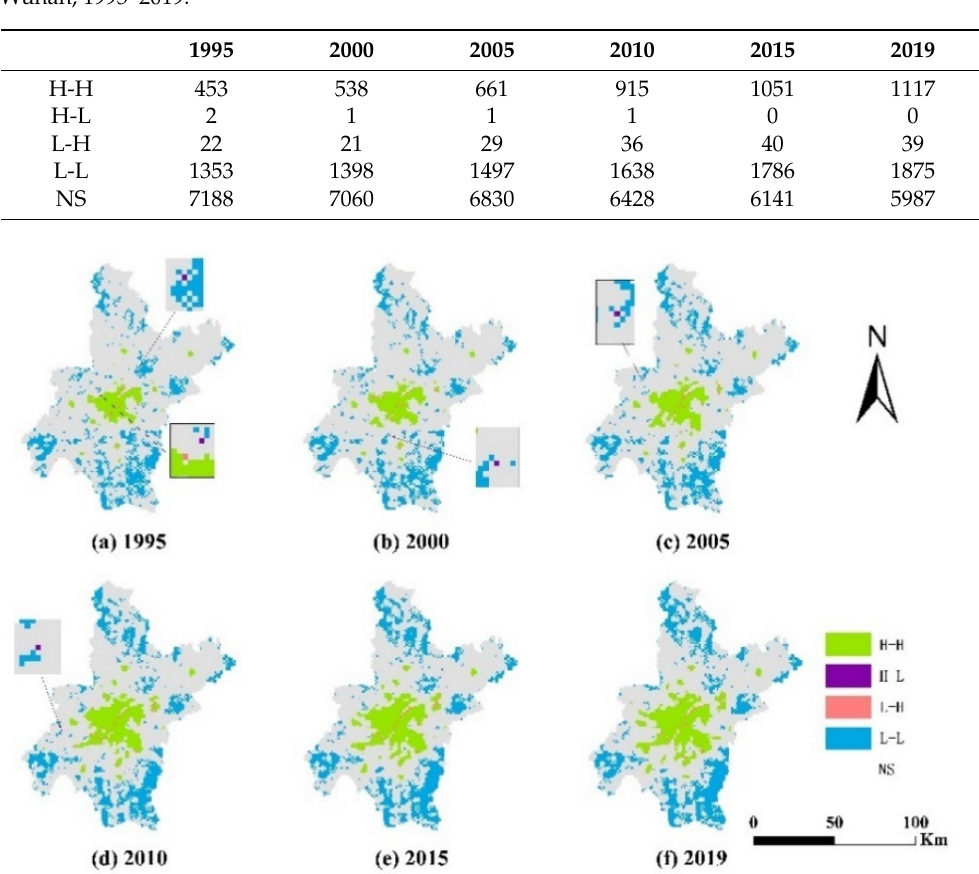
Figure 6. Spatial distribution of spatially localized autocorrelation results between carbon emissions and UCL area in Wuhan,